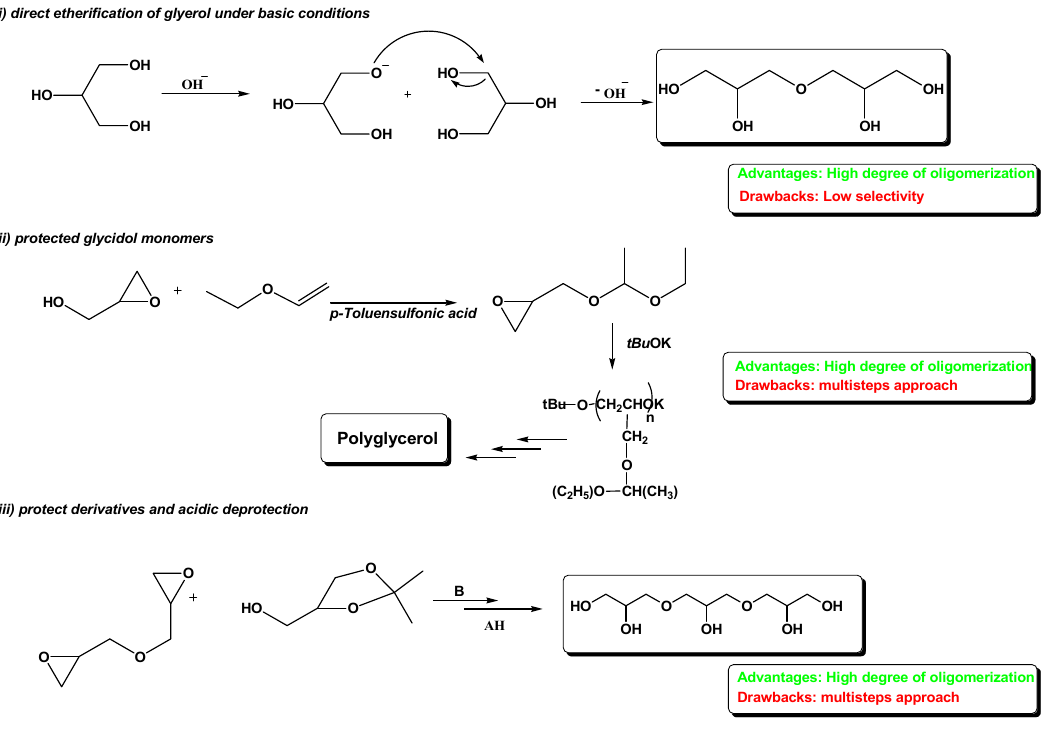
Chart 1. Literature examples for the preparation of polyglycerol.